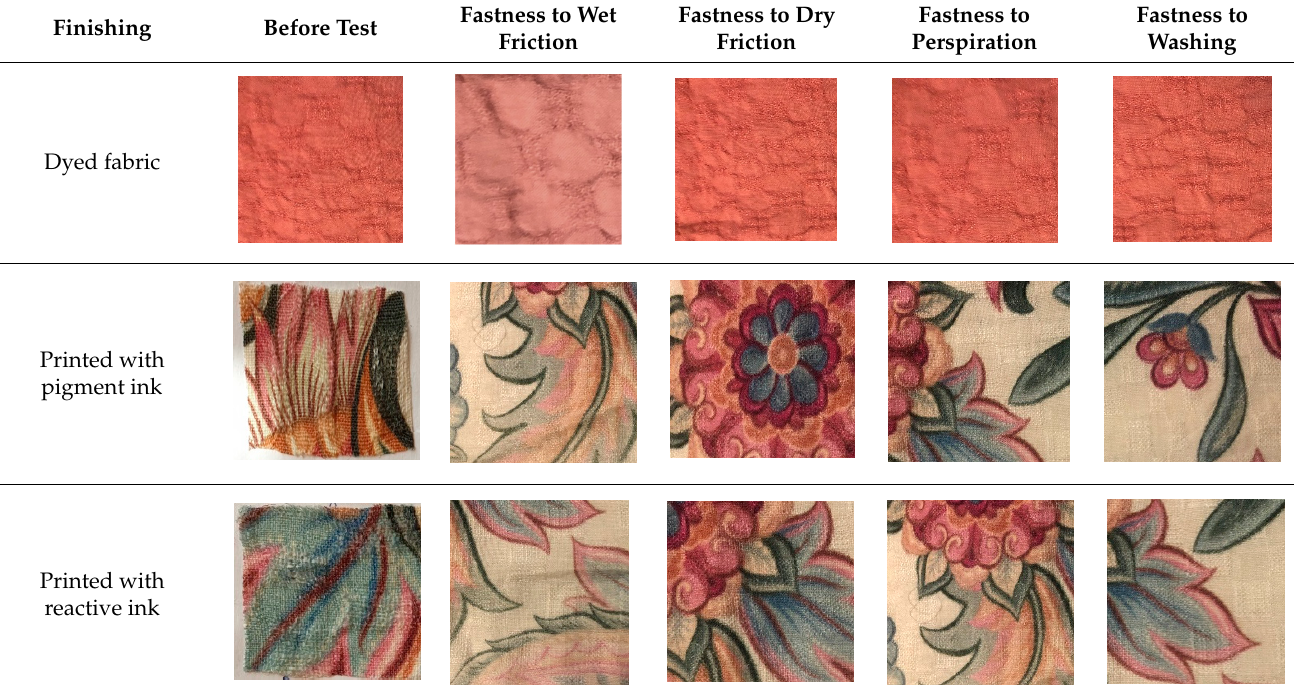
Table 3. Results and evaluations of the fastness of the researched linen/silk fabric.